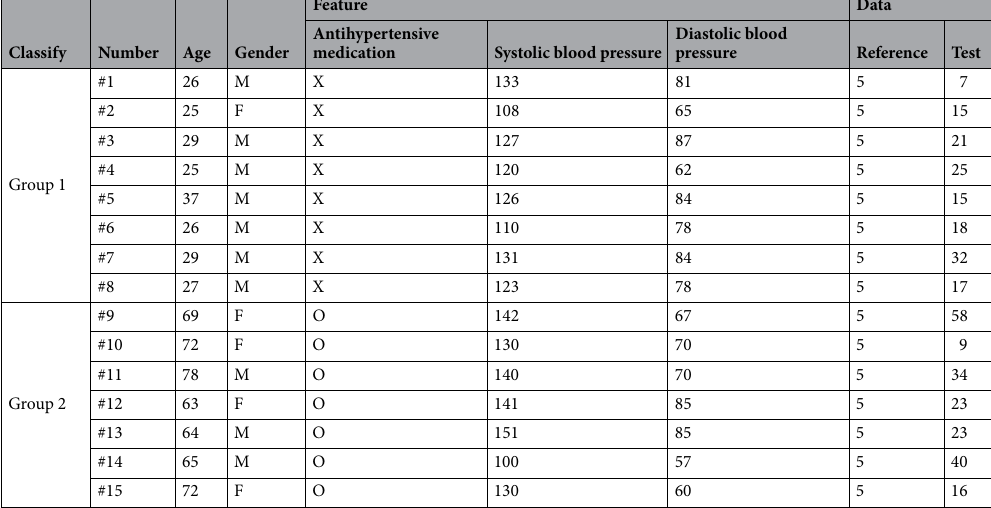
Table 2. Demographic and clinical data of all